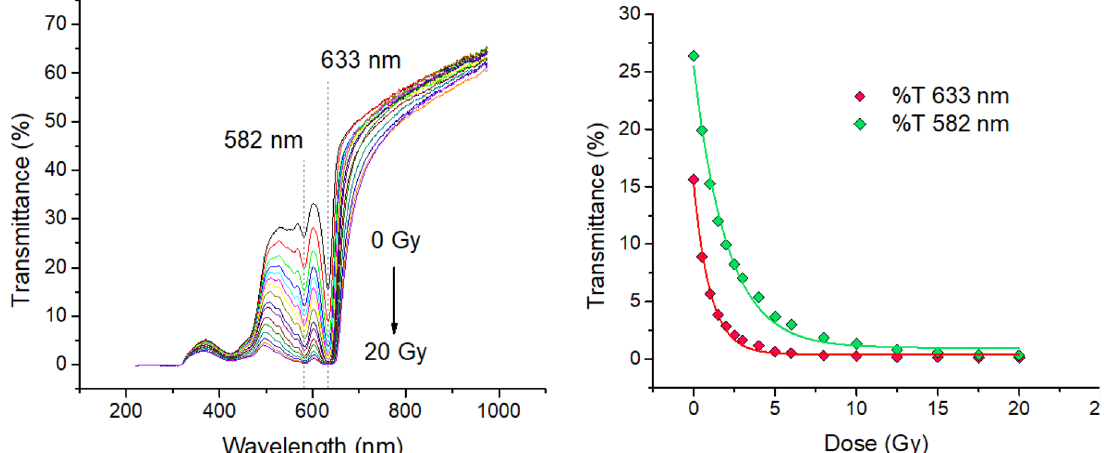
Figure 3. Left: Transmittance spectra of gafchromic EBT3 films irradiated with gammas at different doses. Right: Transmittance values evolution at 582 and 633 nm wavelength depending on the irradiation